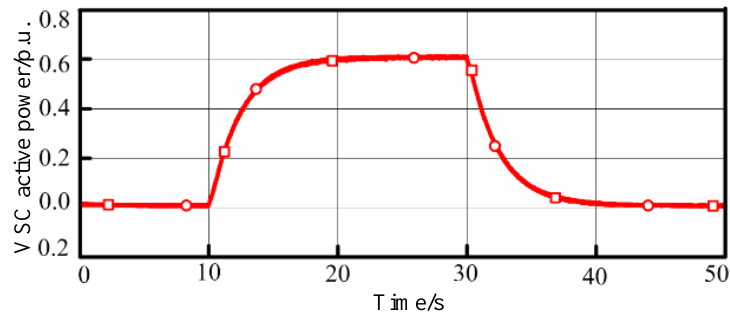
Figure 11. VSC active power curve.